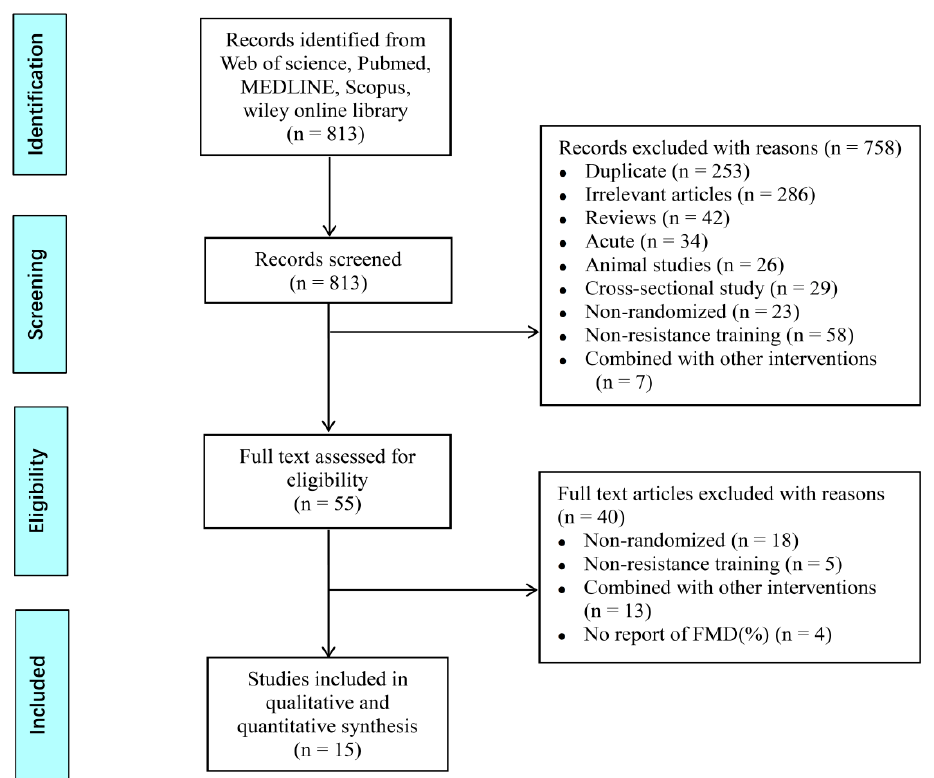
Figure 1. Flow-chart of study selection and exclusion according to the Preferred Reporting Items for Systematic Review and Meta-analysis (PRISMA).